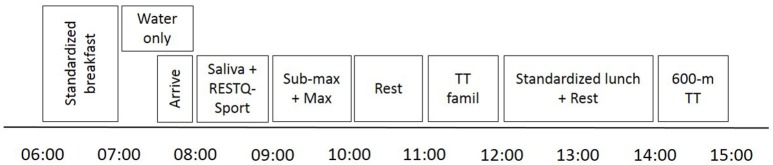
A schematic of the laboratory tests performed before and after the training interventions. RESTQ-Sport: 76-question recovery-stress questionnaire for athletes; Sub-max + Max: sub-maximal and maximal incremental tests; TT famil: 400-m familiarization to the 600-m time-trial (TT).